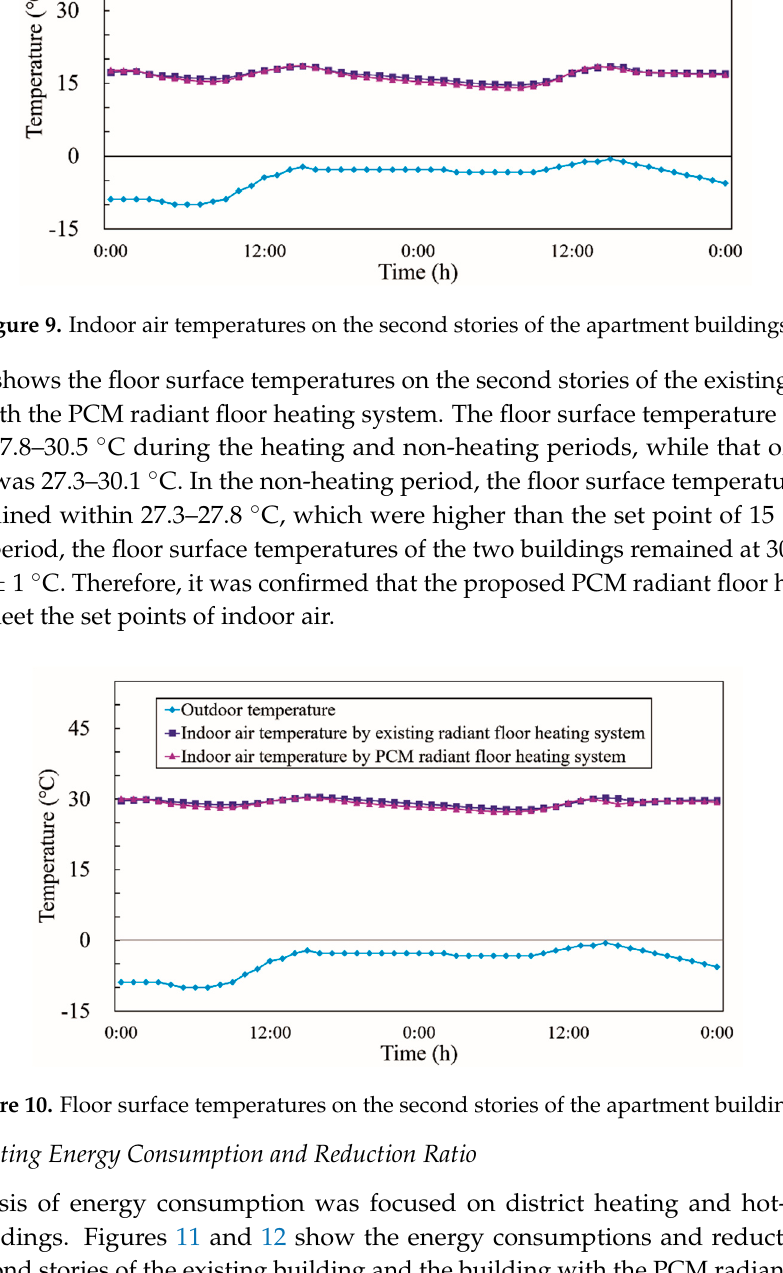
Figure 11. Annual energy consumptions of the PCM radiant floor heating systems. 276